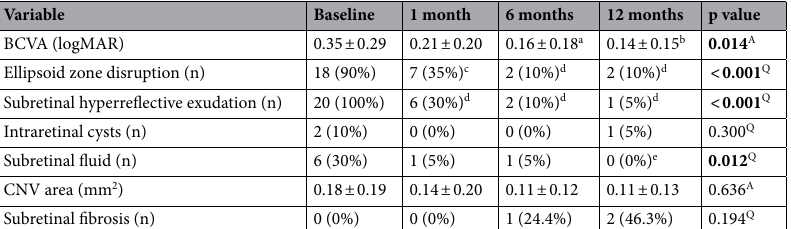
Table 3. Results of repeated variables over the follow-up study period in eyes with mature mCNV (n = 21). Significant values are in bold. A ANOVA test; Q Cochran’s Q test; a 0.046 (Tukey HSD vs baseline); b < 0.001(McNemar vs baseline); c 0.009 (McNemar vs baseline); d 0.012 (McNemar vs baseline); e 0.027 (McNemar vs baseline); f 0.002 (McNemar vs baseline). BCVA Best-Corrected Visual Acuity, CNV Choroidal neovascularization, logMAR logarithm of the minimal angle of resolution, mm millimeter.